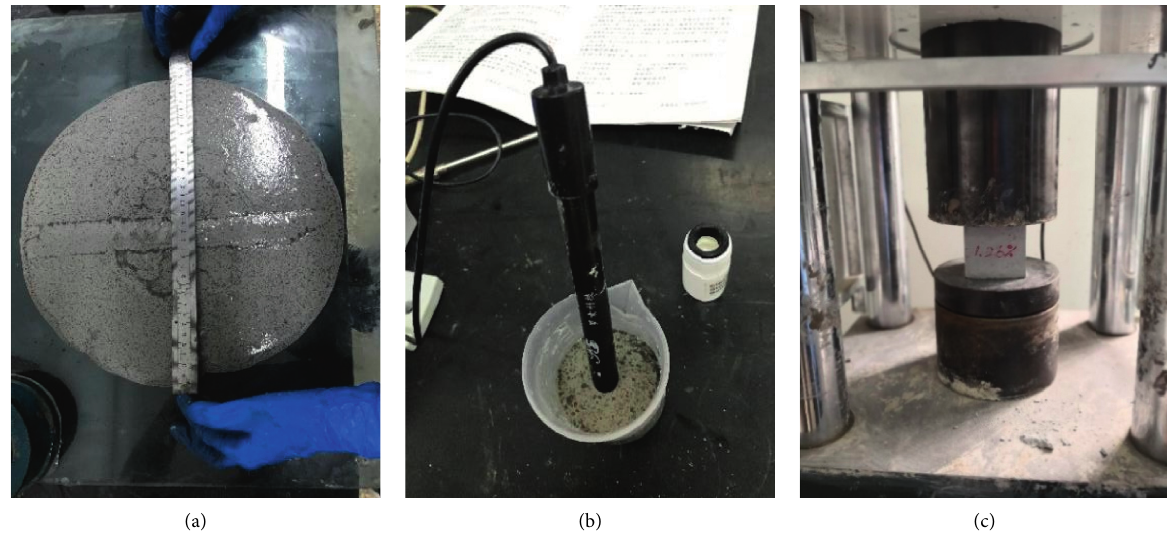
Figure 3: Tests on MPC-based grouting material: (a) fluidity; (b) pH value; and (c) compressive